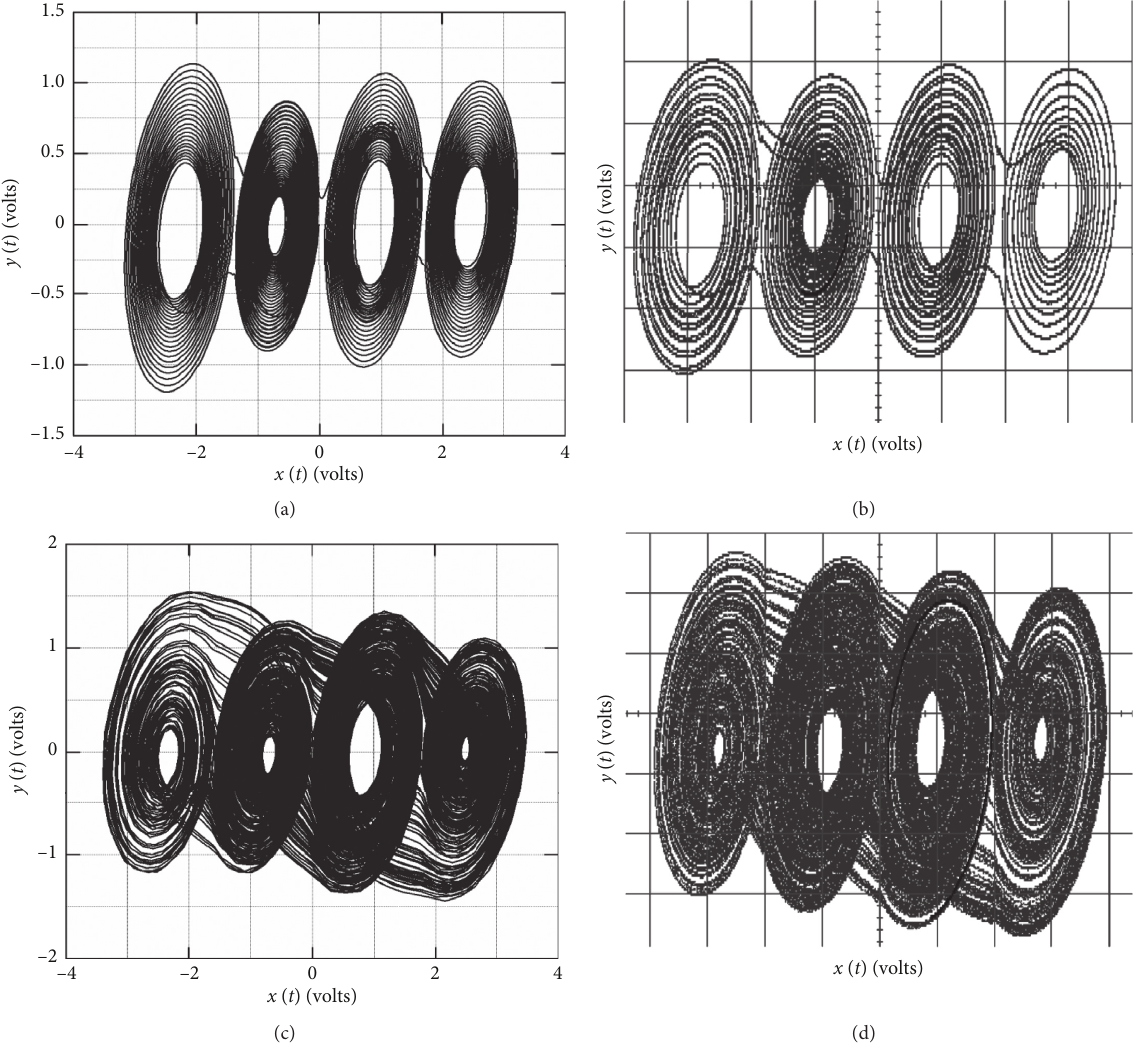
Figure 13: Projection of the 4-scroll chaotic attractor onto xy -plane (phase space portrait): (a) simulation result with α � 0 . 9 (SPICE); (b) experimental result with α � 0 . 9 (oscilloscope scale � 1V per division); (c) simulation result with α � 0 . 95 (SPICE); (d) experimental result with α � 0 . 95 (oscilloscope scale � 1 V per division). Table 4: Comparison of hardware requirements of implemented L¨u fractional-order chaotic oscillators.